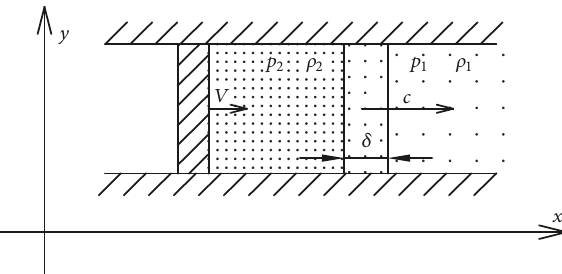
Figure 1: Propagation of a one-dimension compressing wave driven by a moving